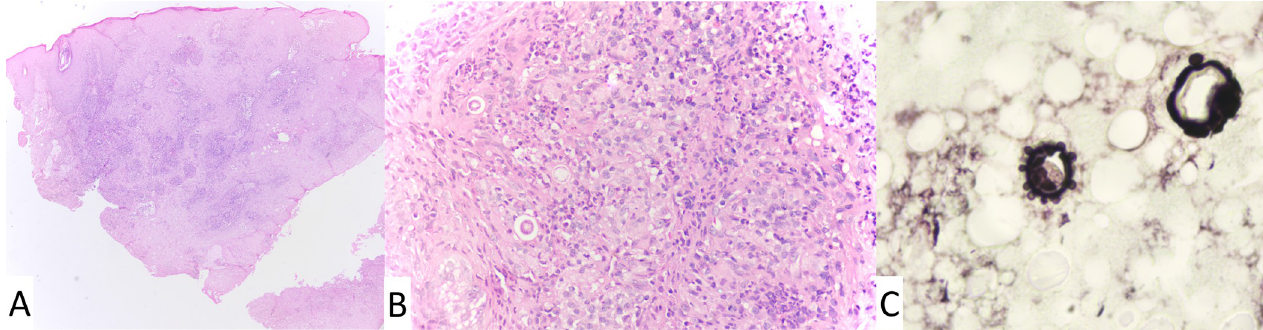
Fig 3. Histopathological examination of the nasal skin. (A) Diffuse dermatitis with pseudoepitheliomatous hyperplasia (HE, 40x); (B) Suppurative granuloma with refringent round fungal forms (HE, 400x); (C) Round structures with multiple budding ("steering wheels") (Grocott 1000x).